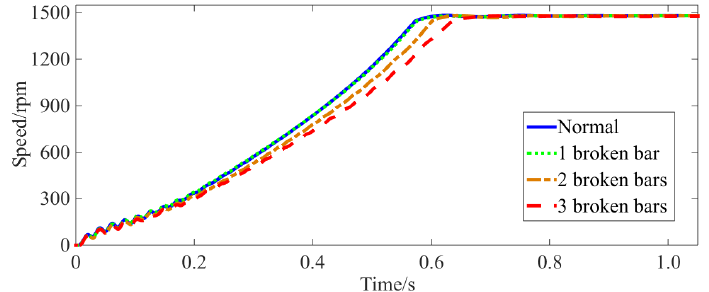
Figure 4. Speed waveforms at different fault levels.